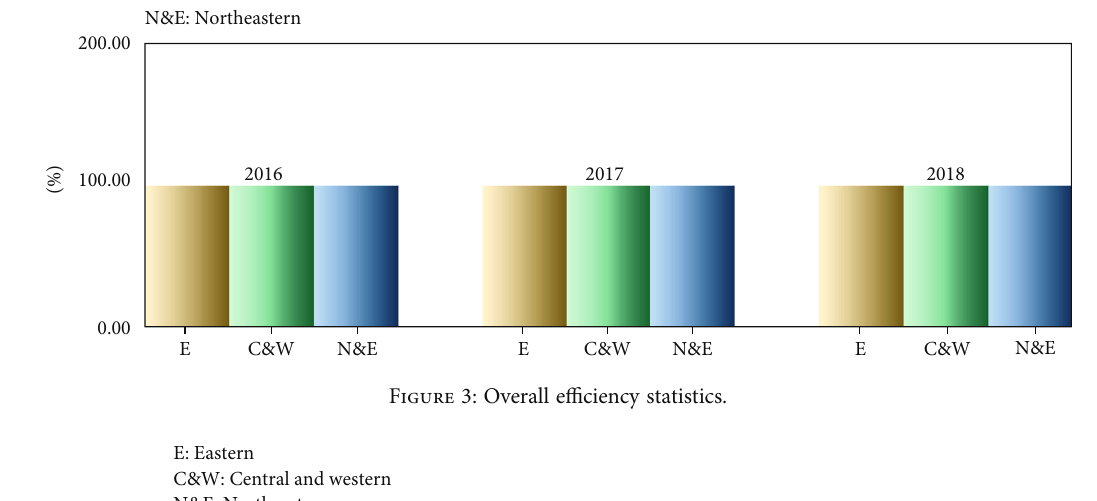
Figure 3: Overall e ffi ciency statistics.